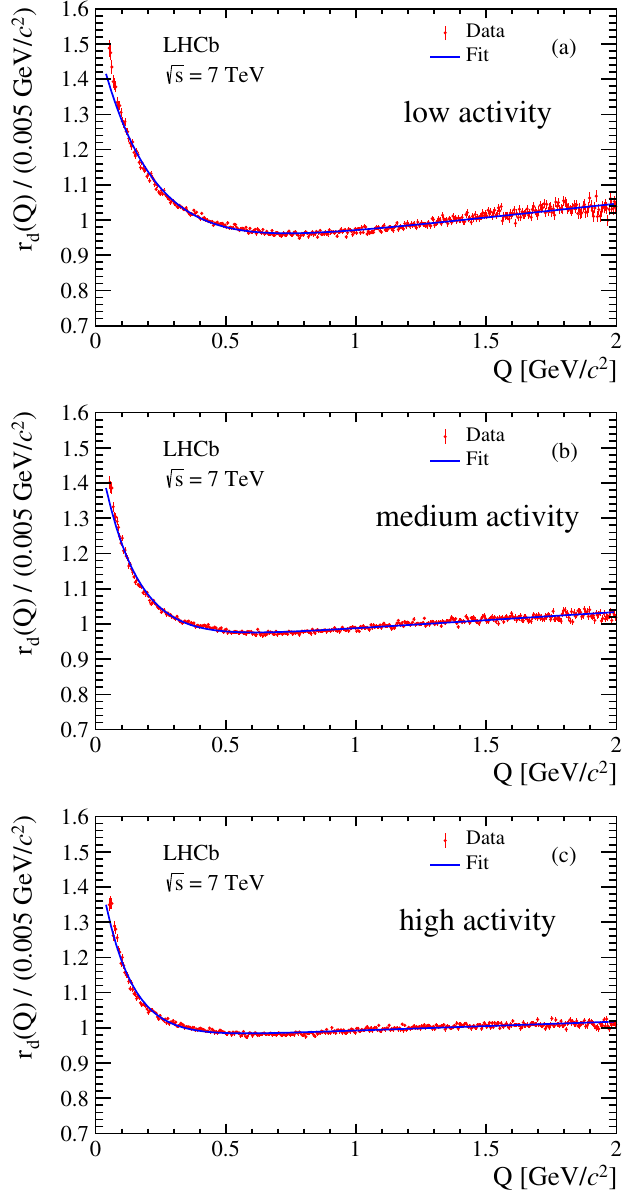
Figure 2 . Results of the (cid:12)t to the double ratio for like-sign pion pairs with event-mixed reference samples and the Coulomb e(cid:11)ect subtracted for the three activity classes: (a) low, (b) medium and (c) high activity. The blue solid line denotes the (cid:12)t result using the parameterisation of eq. (2.3). Only statistical uncertainties are